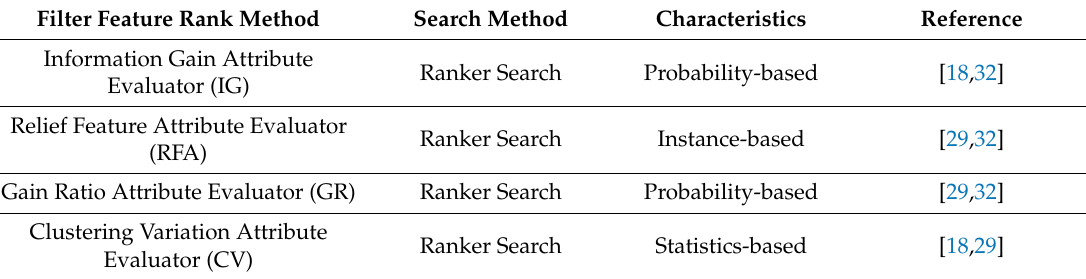
Table 1. List of Filter Feature Ranking (FFR)